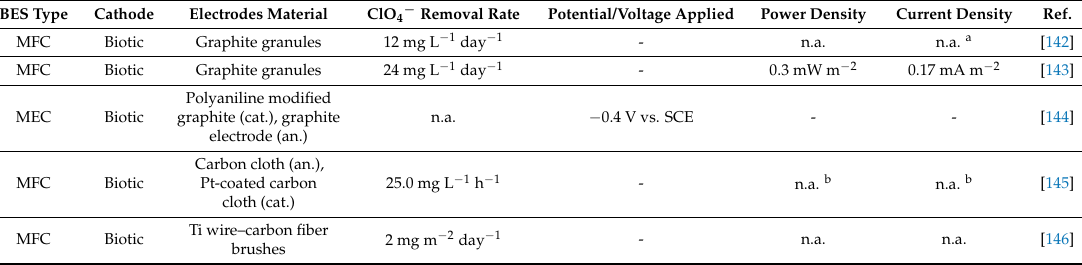
Table 6. Perchlorate removal using